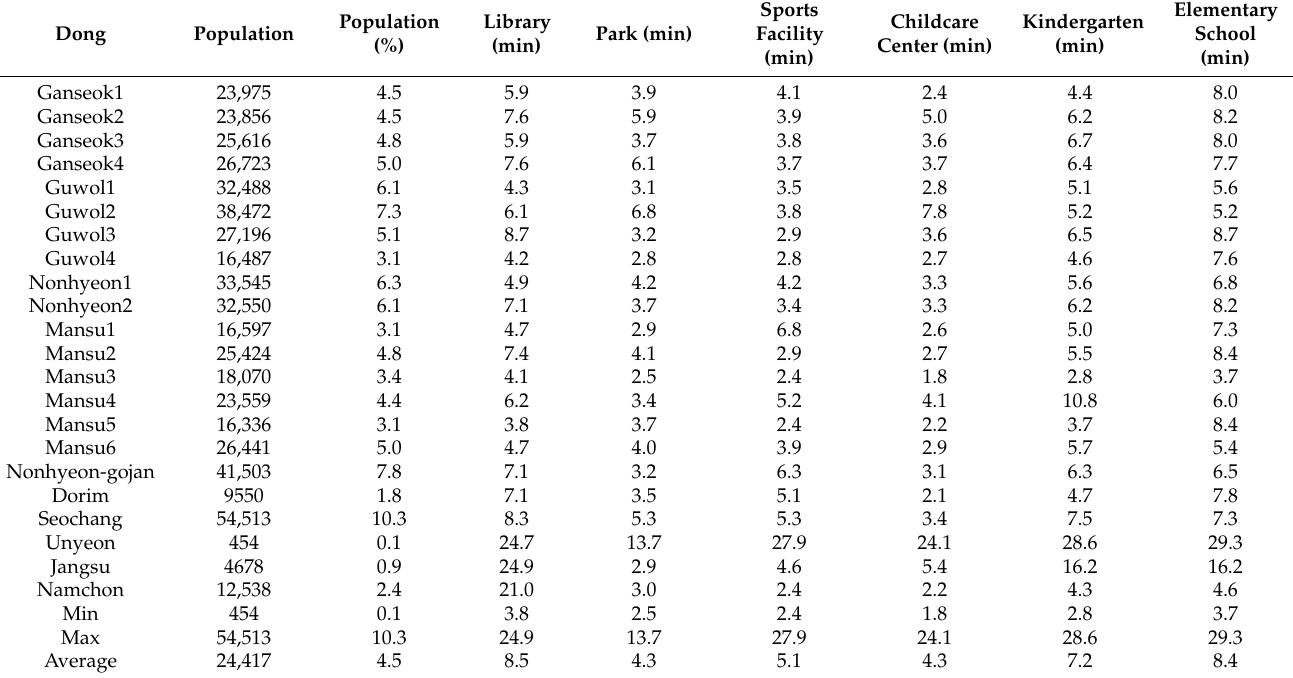
Table 3. AI by dong—walking